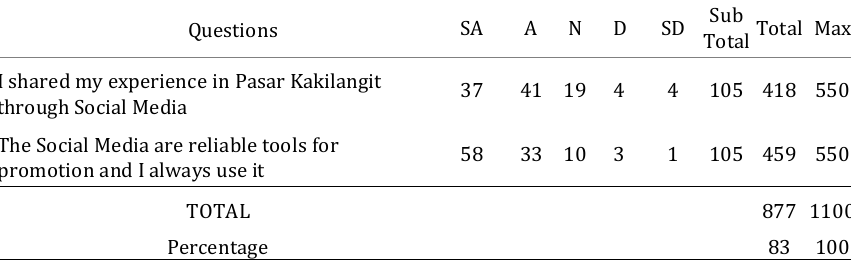
Table 3 Post-Consumption Data Findings